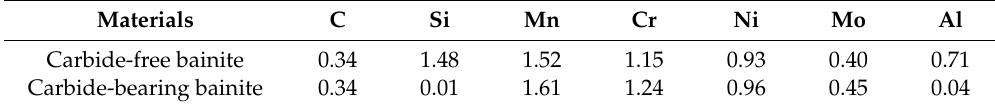
Table 1. Chemical composition of tested bainitic steels,